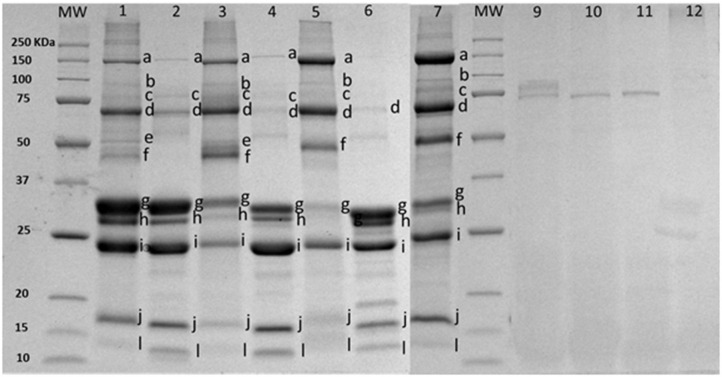
SDS-PAGE pattern of milk fat globule membrane (MFGM) proteins in milk and MFGM purified before and after digestion. MW, molecular weight marker (KDa). The MFGM proteins are from phospholipid concentrated (lane 1), bovine milk (lane 2), bovine MFGM (lane 3), caprine milk (lane 4), caprine MFGM (lane 5), ovine milk (lane 6), ovine MFGM (lane 7), material remaining after digestion for bovine MFGM (lane 9), caprine MFGM (lane 10), ovine MFGM (lane 11), and phospholipid concentrated (line 12). Proteins were identified accordingly with MW as (a) xanthine oxidase (~145 kDa), (b) PAS III (~100 kDa), (c) CD36 (~75 kDa), (d) butyrophilin (64 kDa bovine, 67 kDa caprine), (e) or (f) adipophilin (50–52 kDa) or lactadherin (PAS 6/7; 52–58 kDa bovine, 55 kDa caprine), (g) α-caseins (~22–25Kda), (h) β-caseins (~23–24 kDa), (i) κ-caseins (~19 kDa), (j) β-lactaglobulin (~18 kDa), and (l) α-lactalbumin (~14 kDa).